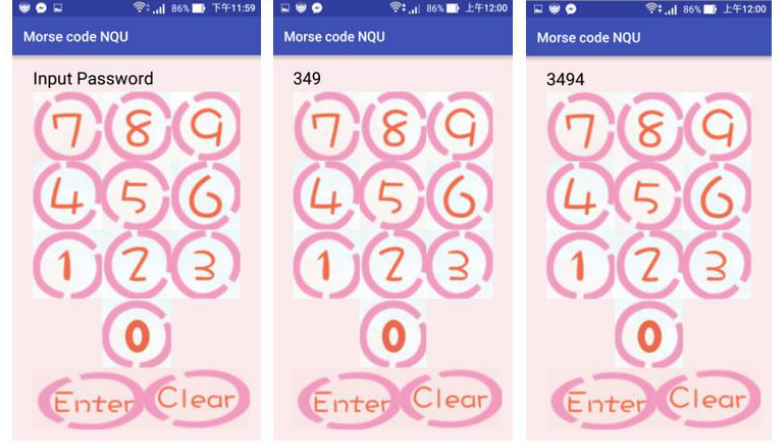
Figure 14. The Morse code app user interface.